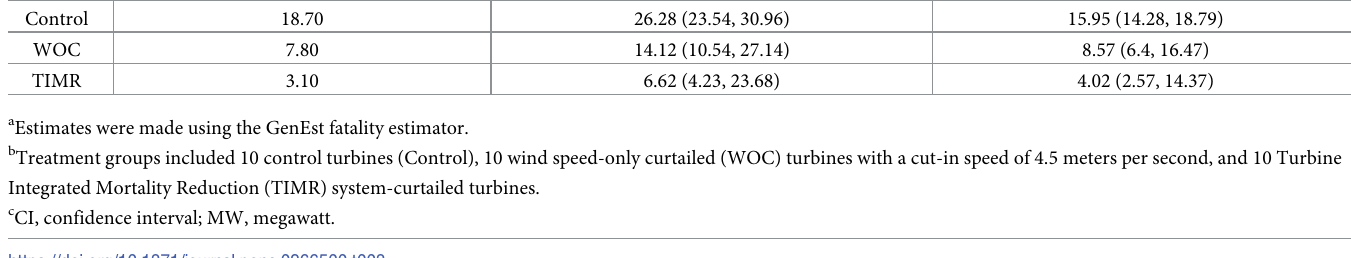
Table 3. Observed and estimated bat fatalities for 3 treatment groups at the Blue Sky Green Field Wind Energy Facility, Fond du Lac County, Wisconsin, from July 15 − September 30, 2015 a . Treatment b Observed fatalities